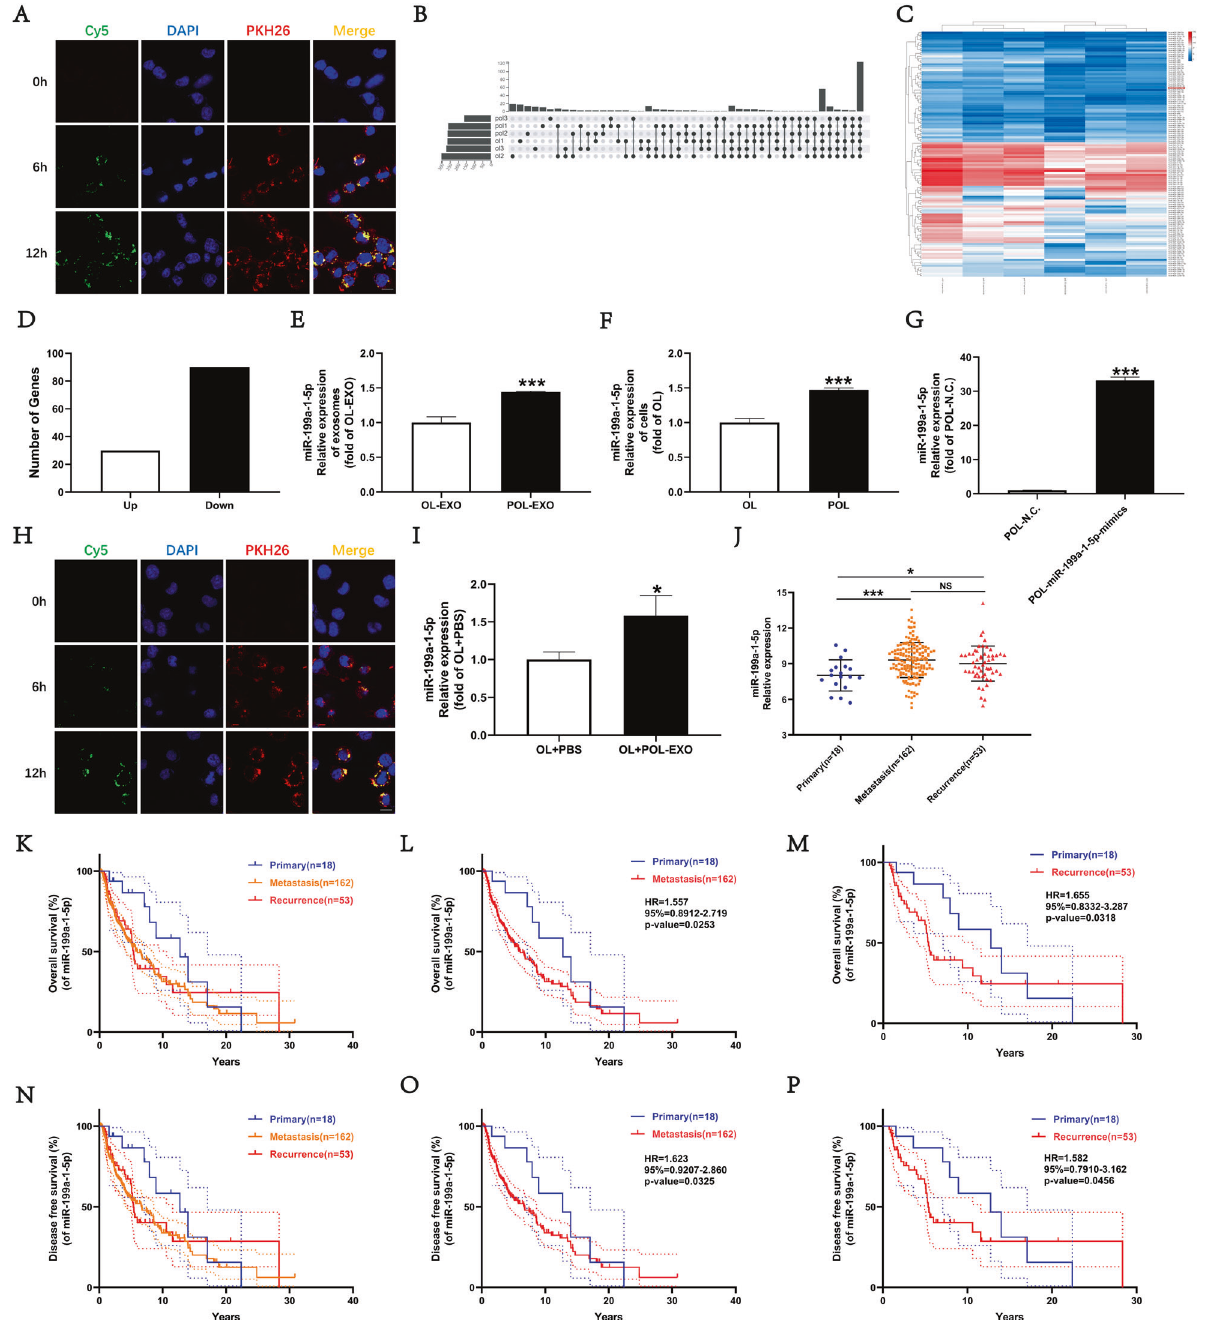
Fig. 2 The expression levels of miR-199a-1-5p are signi fi cantly increased in POL and POL-EXO, and is enhanced in the OL upon uptaking of POL-exo. A Imaging analysis of the time course of OL uptake of exosomes secreted by POL-N.C., bar = 10 μ m. Wien diagram ( B ) and Heat map analysis ( C ) of miRNAs secreted by OL and POL cells. D Differentially expressed miRNAs between POL-exo and OL-exo. miR-199a-1-5p expression in OL-exo and POL-exo ( E ) and in OL and POL cells ( F ) evaluated by RT-qPCR. ***P < 0.001. G miR-199a-1-5p expression in POL-N.C. and POL-miR-199a-1-5p-mimics evaluated by RT-qPCR. ***P < 0.001. H Imaging analysis of the time course of OL uptake of exosomes secreted by POL-miR-199a-1-5p-mimics cells, bar = 10 μ m. Wien diagram. I miR-199a-1-5p expression in OL + PBS and OL + POL-miR-199a-1-5p- mimics-Exo evaluated by RT-qPCR. *P < 0.05. J TCGA analysis of miR-199a-1-5p gene relative expression in melanoma. K – P The Kaplan-plot of miR-199a-1-5p gene in patients with